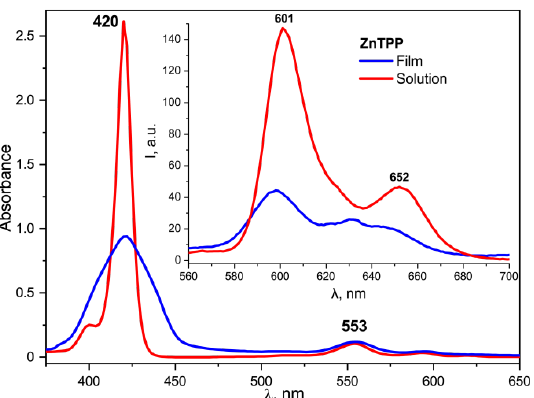
Figure 14. Comparison of the absorption and fluorescence (insert) spectra for ZnTPP in the acetone solution and in the copolymer film crystallized from acetone.